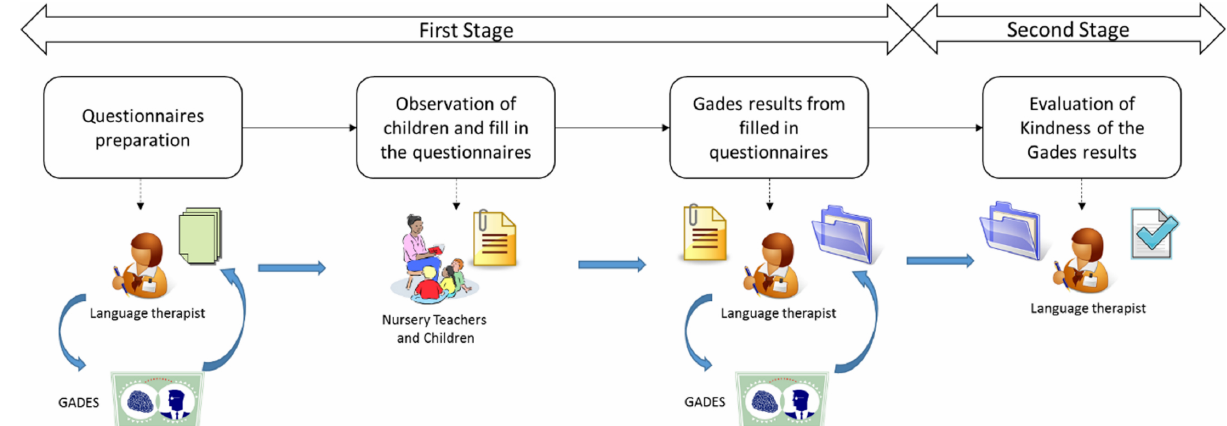
Figure 2. Evaluation method for early detection of language disorders.